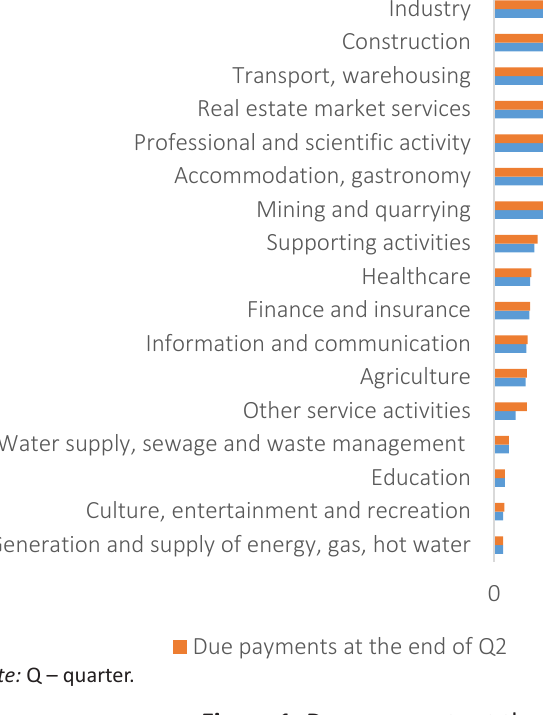
Figure 1. Due payments at the end of Q1 and Q2 by industry